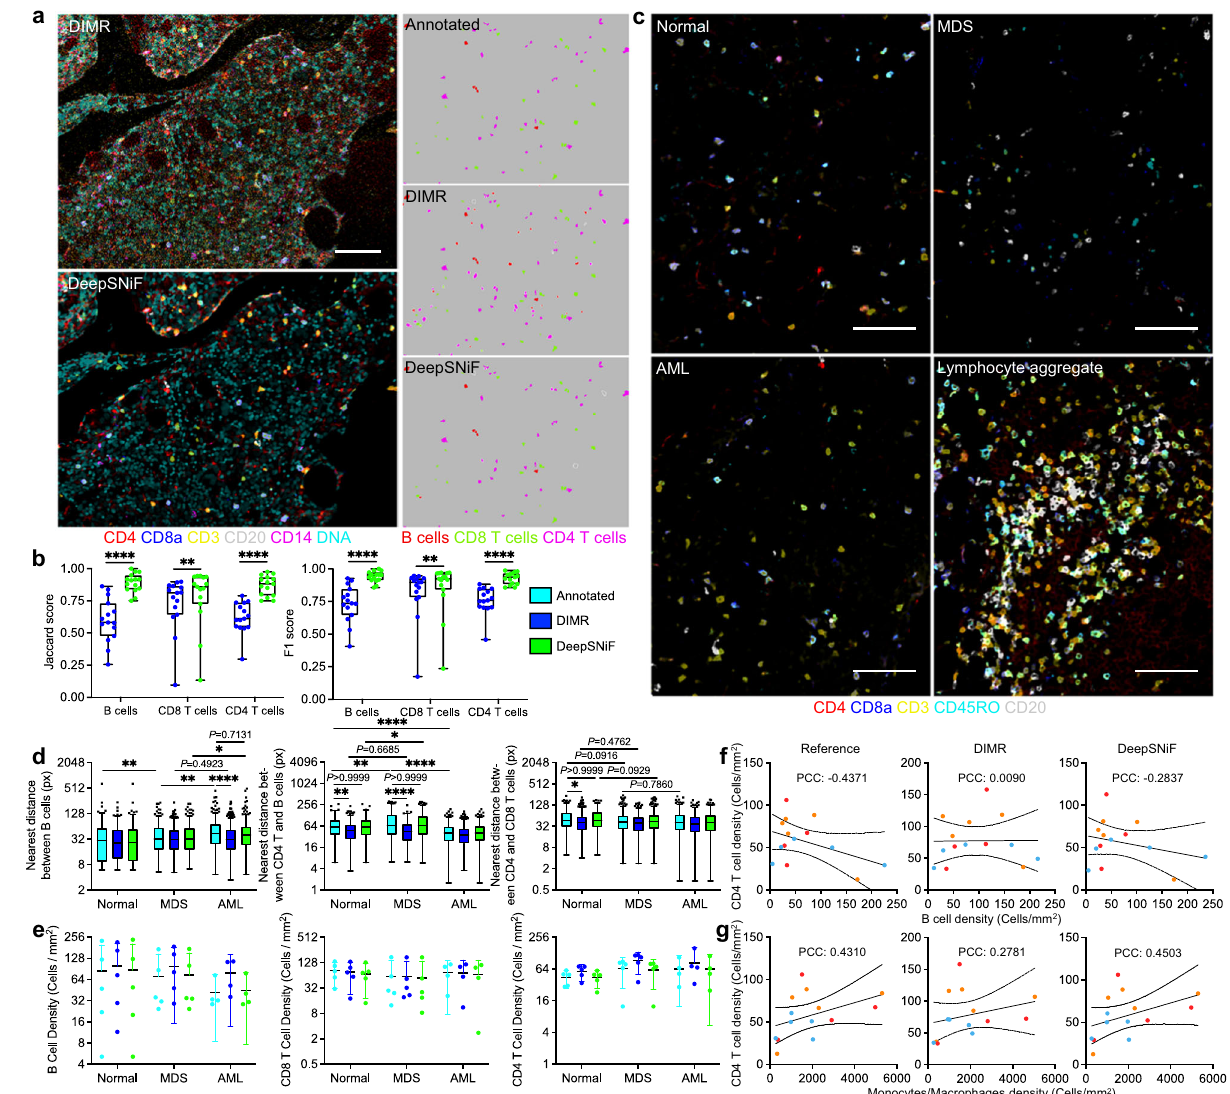
Fig. 4 | DeepSNiF enhances lymphocyte analysis. a Manual annotations for lymphocytes and comparisons with DIMR and DeepSNiF phenotyping results with DeepSNiF-based cell masks. The white contours represent the differential pheno- typing results between the annotated and DIMR/DeepSNiF results. b Annotation evaluations of DIMR and DeepSNiF by both Jaccard and F1 scores across all the tissues( n =15biologicallyindependentsamples).Boxcenterindicatesmedian,box edges25thand75thpercentile,andwhiskersminimumandmaximumpercentile. P valueswerecalculatedthroughtwo-sidedWilcoxonmatched-pairedtest(** P <0.01 and **** P <0.0001). c Representative images of lymphocyte markers after DeepS- NiF denoising from specimens of normal (upper left), myelodysplastic syndromes (MDS, upper right), acute myeloid leukemia (AML, lower left) and AML with lym- phoid aggregate (lower right) tissue samples. d Nearest distance comparisons between different cell types of normal ( n =5 biologically independent samples), MDS ( n =5 biologically independent) samples and AML ( n =4 biologically inde- pendent samples) tissues from manual, DIMR and DeepSNiF phentyping